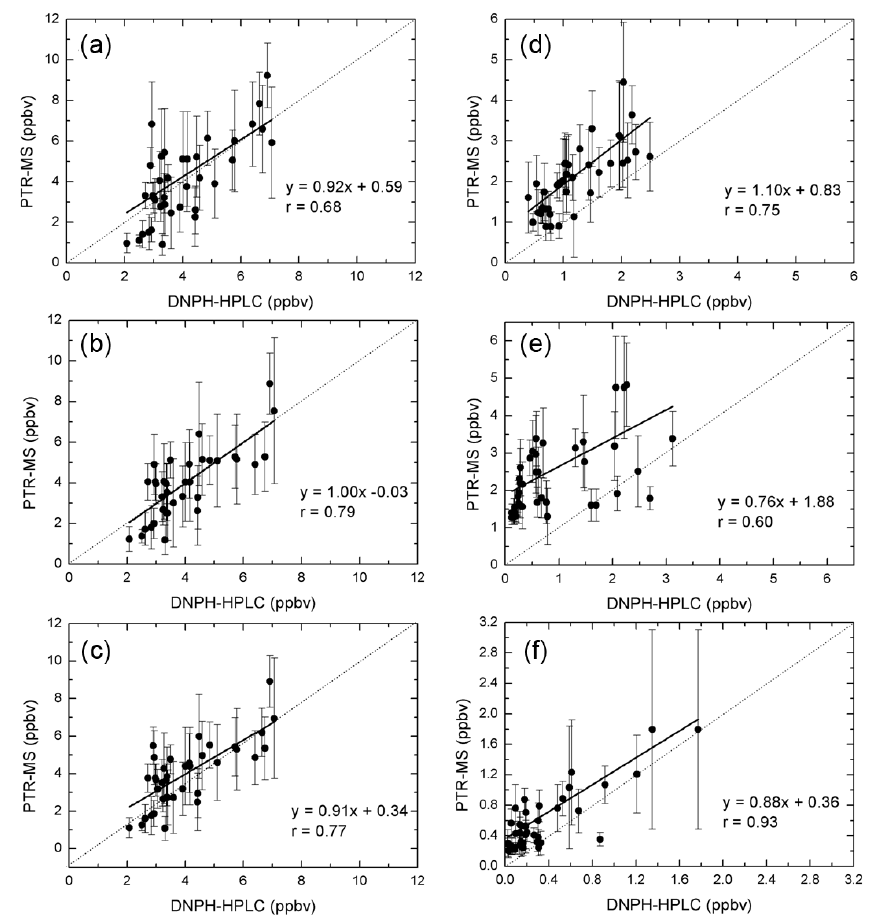
Figure 9. Intercomparison between ambient OVOC measurements by PTR-MS and by DNPH-HPLC during the field study at MK in Hong Kong: (a) formaldehyde without correction, (b) formaldehyde corrected by R (RH, T ), (c) formaldehyde corrected by k (AH), (d) acetalde- hyde, (e) acetone, and (f) MEK. Linear regression fits are indicated by the solid black line. Error bar stands for the standard deviation of 24h averaged PTR-MS data. Dashed line is the 1 : 1 line for